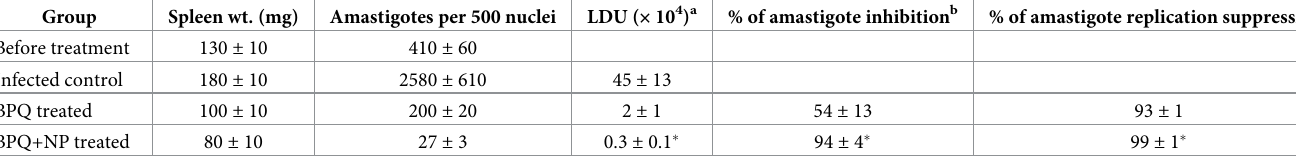
the selectivity index (SI); the higher the SI value, the more selective the drug was to kill the amastigotes while the cellular toxicity was diminished. According to the SI values, BPQ+NP were clearly more selective in comparison with pure BPQ as well as other conventional drugs against both the wild-type and the drug-resistant strains. It should be noticed in Tables 2 and 3 that there was cross-resistances of (AG83-R, PMM) to SSG and (AG83-R, SSG) to PMM. Treatment efficacy on in vivo intracellular amastigotes LDU assay. In LDU experiment spleens were taken for determination of organ weight and parasite burden to the immediate effects of drugs and nanoformulation on intracellular amastigotes (Table 4). The mice were treated for 5 consecutive days (1 mg/kg). Parasite burden in vivo was assessed by microscopic observation of amastigotes against host cell nuclei on tis- sue imprints and expressed as LDU values. The amastigote burden in spleen in the groups treated with BPQ and BPQ+BP was low. The amastigote burden in spleen was reduced more effectively by 20-fold and 170-fold in the BPQ and BPQ+NP treated groups, respectively when compared with the control group. Crucially, the inhibition of the amastigotes with BPQ+NP reached nearly 100% while with pure BPQ, it was only around 50%. Nevertheless, the amasti- gote replication suppression by BPQ was over 90% either with or without the use of the nanoparticles. ple microscopic observation may lack some amastigotes in stained organ. We carried out more Table 4. In vivo responses to amastigotes in the spleen of infected mice using LDU assay (mean ± σ , n = 5). Group Spleen wt.